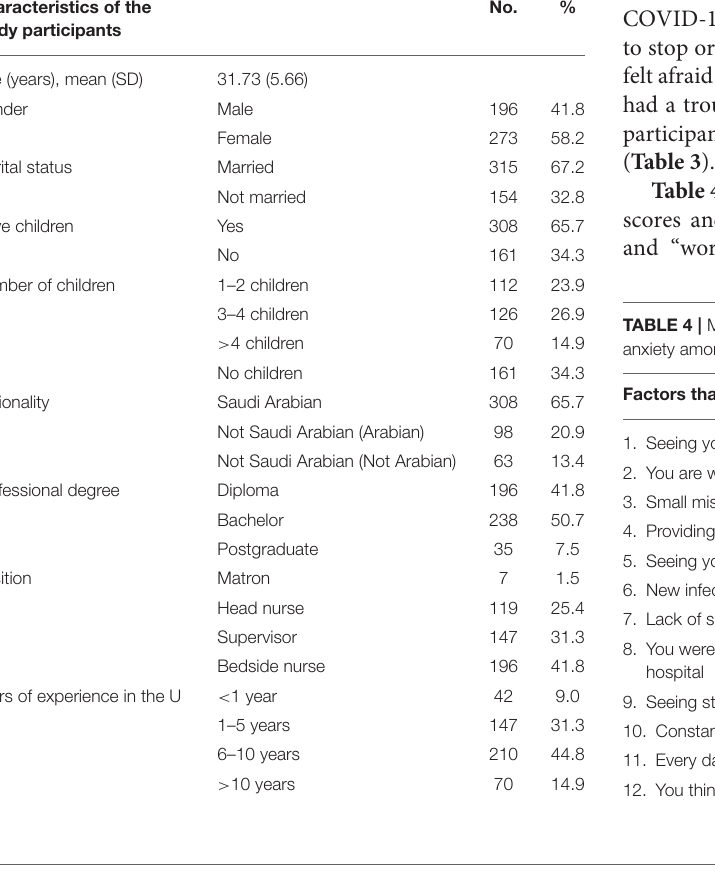
TABLE 1 | Characteristics of the study participants ( n = 469). Characteristics of the study participants